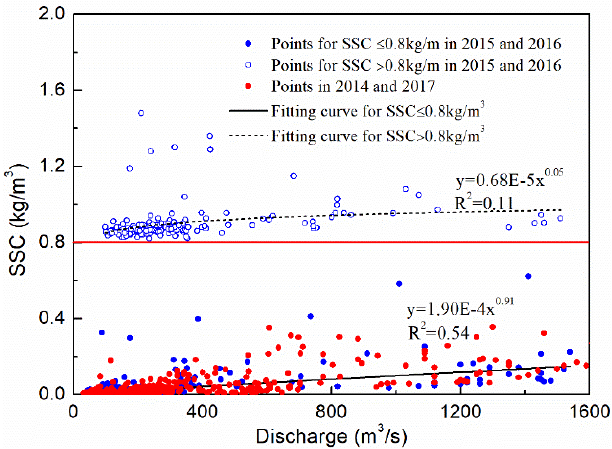
Figure 9. Sediment rating curve at the Lhasa Station.